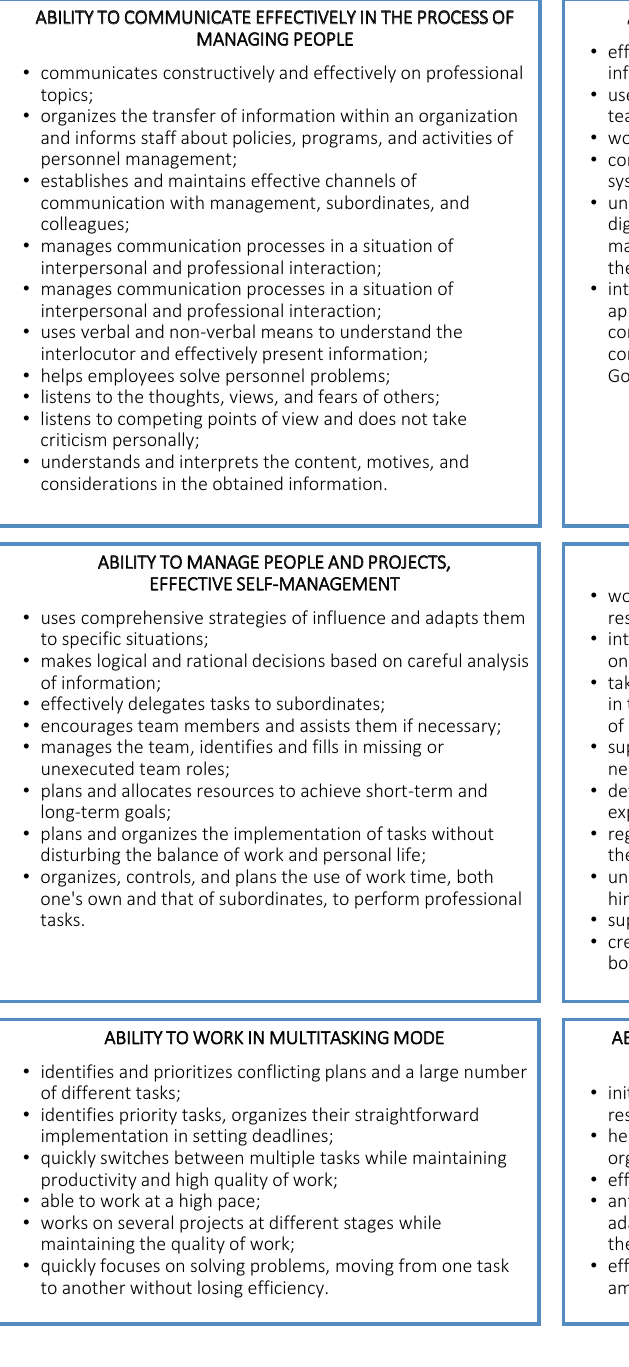
Figure 7. Behavioral indicators of transferable competencies of personnel